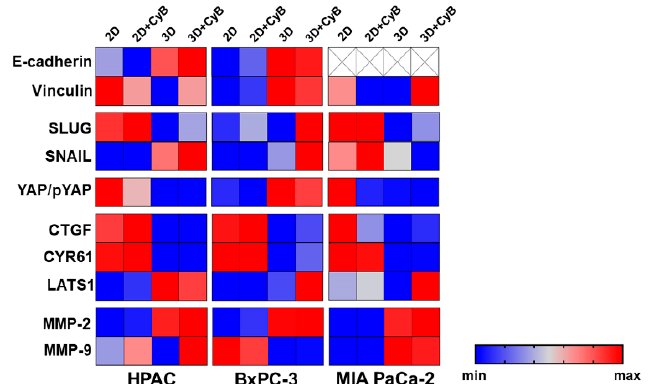
Figure 13. Heatmap summarizing all the results relative to the analysis of PDAC cells in the different experimental conditions. The bar on the right shows how colors map to numeric values.